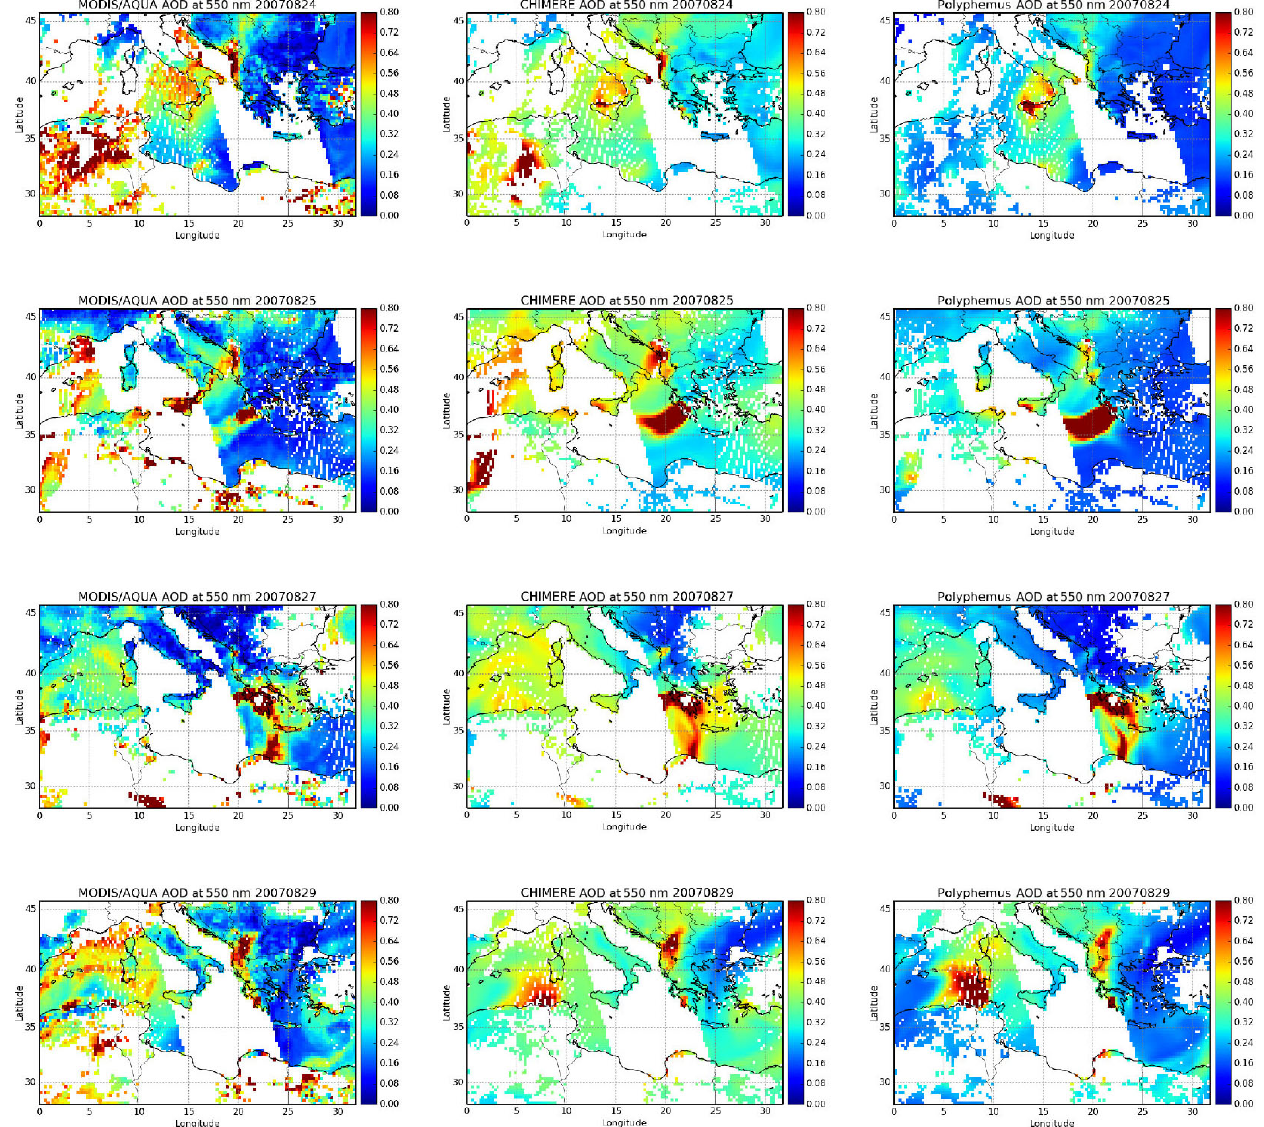
Figure E1. Total AOD (at 550nm) from MODIS/AQUA and the corresponding Polyphemus AOD ( Poly-ref ) and CHIMERE AOD ( CHIMERE-ref ) for four selected days (24, 25, 27 and 29 August